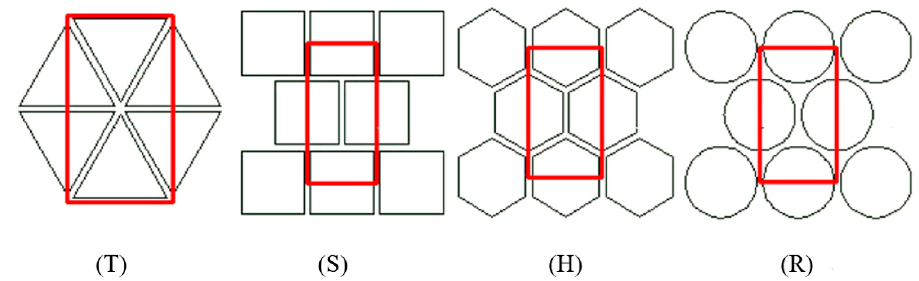
Figure 8. The simulation units of four cross-grooved texture: (T) triangle-textured; (S) square-tex- tured; (H) hexagon-textured; (R) round-textured.